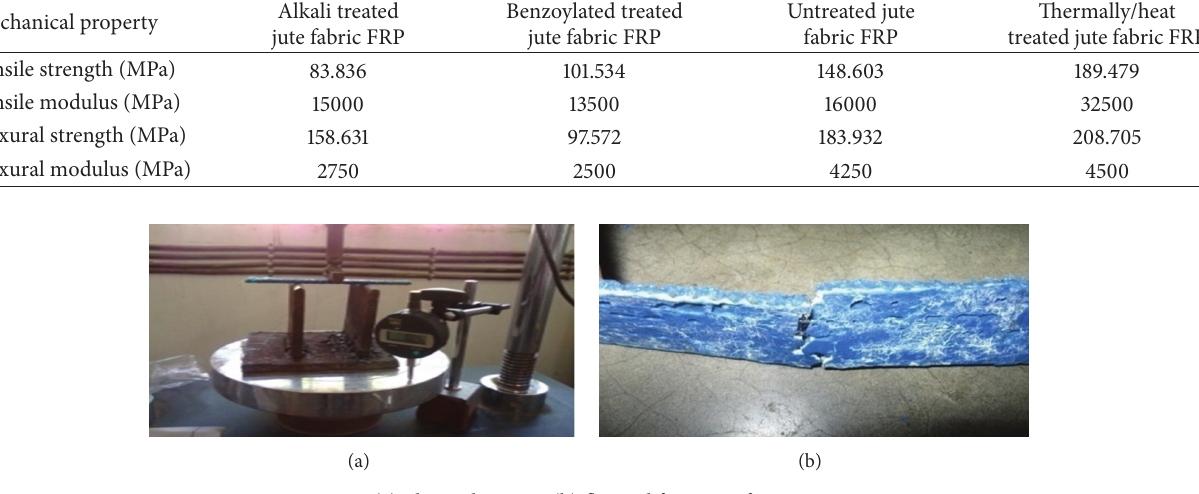
Figure 2: (a) Flexural testing; (b) flexural fracture of woven jute